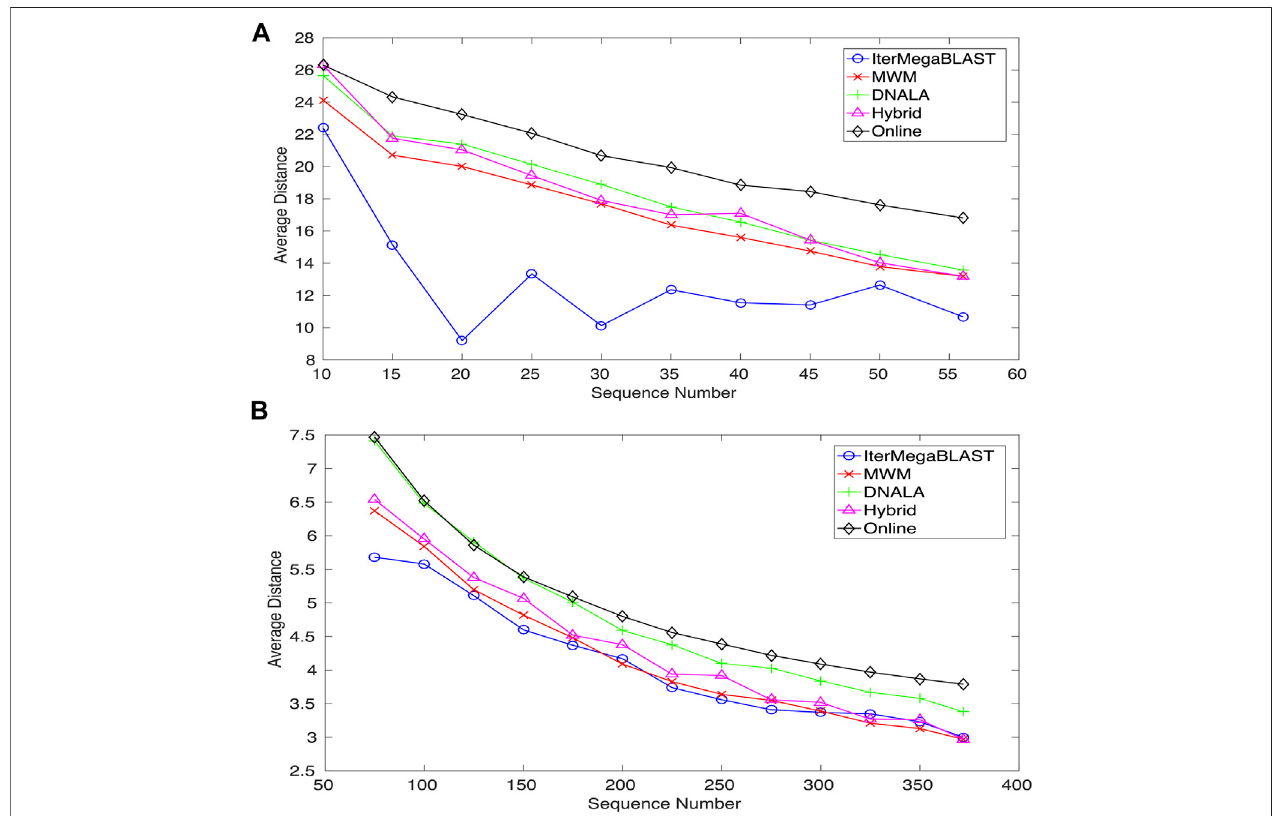
FIGURE 4 | The average distances of IterMegaBLAST varying with respect to the number of DNA sequences for (A) Dataset I and (B) Dataset II. The shorter the distanceis,thelesstheinformationloss.DNALAisfrom(Malin,2005b),whileMWM,HybridandOnlinealgorithmsarefrom(Lietal.,2012).IterMegaBLASTisthemethod proposed in this paper.